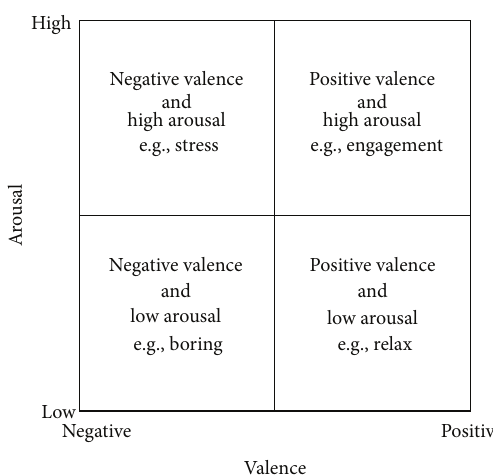
Figure 1: The classic valence-arousal model [2, 3] with the two dimensions of “activation”: physiological arousal and emotional valence.